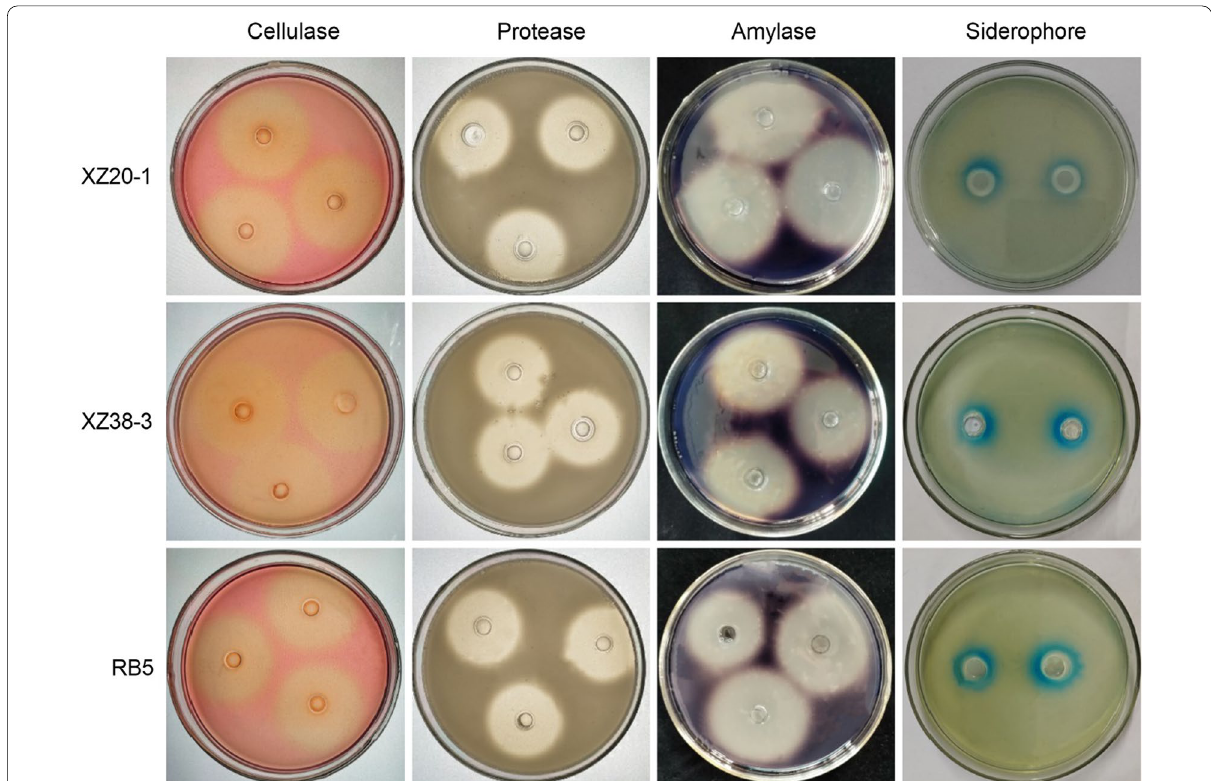
Fig. 2 Detection of bioactive substance from Bacillus amyloliquefaciens XZ20-1, Bacillus velezensis XZ38-3 and Pseudomonas fluorescens